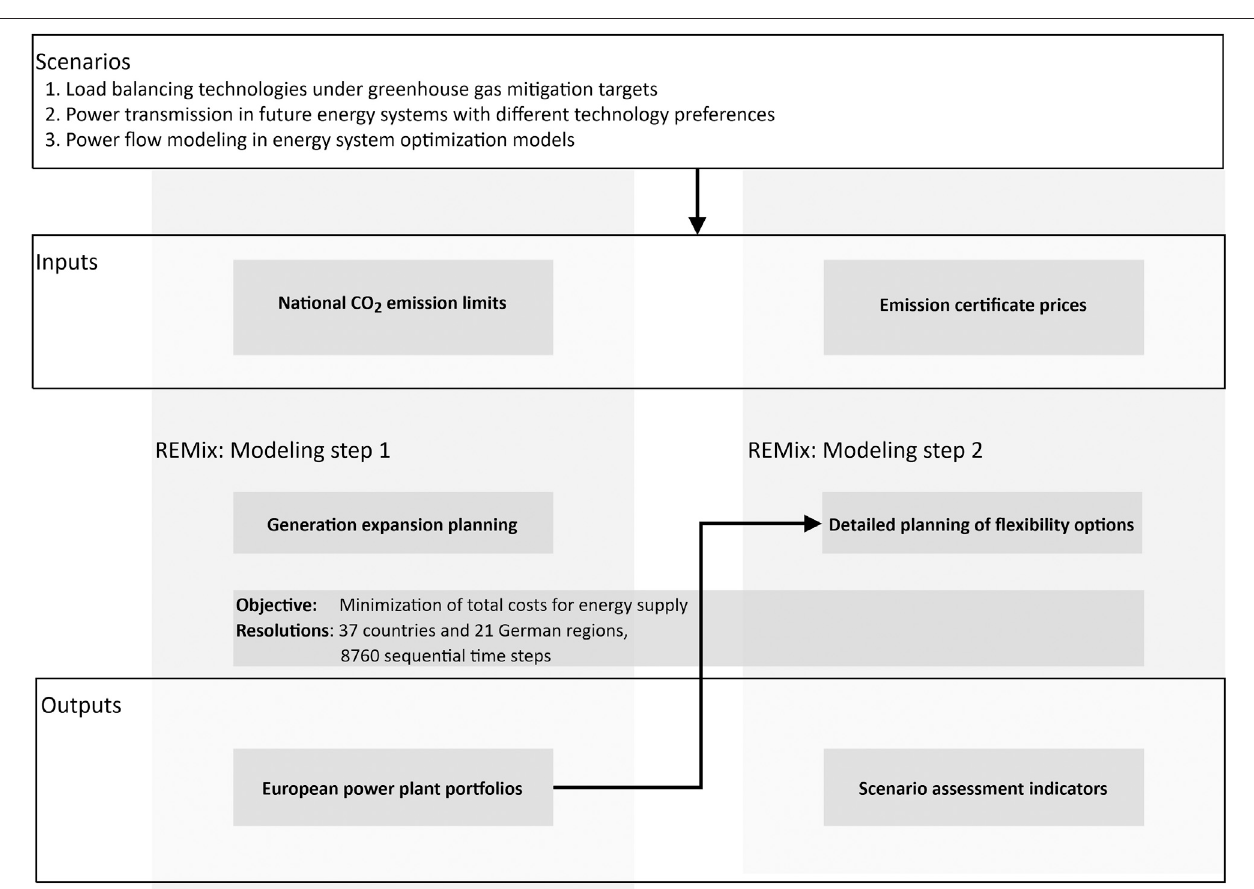
FIGURE 1 | Overview of methods, including inputs, scenarios, and outputs. Our modeling approach has two steps: step one performs a classical expansion plan and step two a detailed planning of numerous fl exibility options.